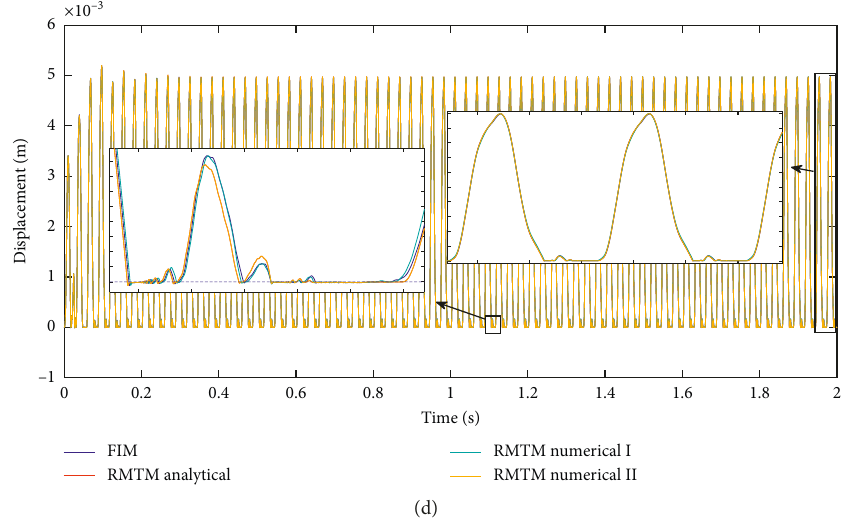
Figure 6: Time-history response of soft impact and hard impact using FIM and RMTM. (a) Five-mode discretization: damping ratio ξ � 0 . 02, ω � 60 Hz; soft impact k ∗ � 1 . 3 ( k � 1 × 10 3 N/m ) ; zero-crossing threshold ε y < 1 × 10 − 14 ; and step Δ t � 1 × 10 − 5 . (b) Five-mode discretization: damping ratio ξ � 0 . 02; ω � 100 Hz; hard impact k ∗ � 13000 ( k � 1 × 10 7 N/m ) ; zero-crossing threshold ε y < 1 × 10 − 14 ; and step Δ t � 1 × 10 − 5 . (c) Twenty-mode discretization: damping ratio ξ � 0 . 02; ω � 60 Hz; soft impact k ∗ � 1 . 3 ( k � 1 × 10 3 N/m ) ; zero- crossing threshold ε y < 1 × 10 − 14 ; and step Δ t � 1 × 10 − 5 . (d) Twenty-mode discretization: damping ratio ξ � 0 . 02, ω � 70 Hz; hard impact k ∗ � 13000 ( k � 1 × 10 7 N/m ) ; FIM, RMTM analytical, and RMTM numerical I: zero-crossing threshold ε Δ t � 1 × 10 − 5 . RMTM numerical II: zero-crossing threshold ε y < 1 × 10 − 16 and step Δ t � 1 × 10 − 6